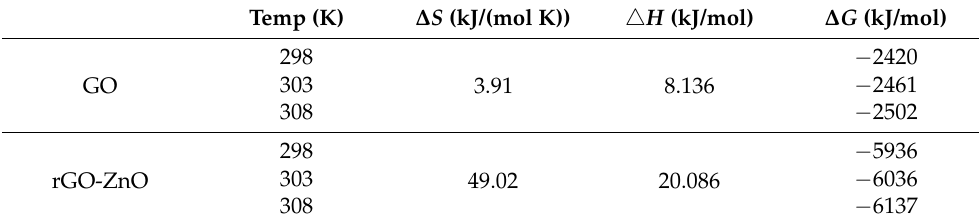
Table 3. Thermodynamic parameters for Cr (VI) sorption by GO and rGO-ZnO. Temp (K) ∆ S (kJ/(mol K)) (cid:52) H (kJ/mol) ∆ G (kJ/mol) GO